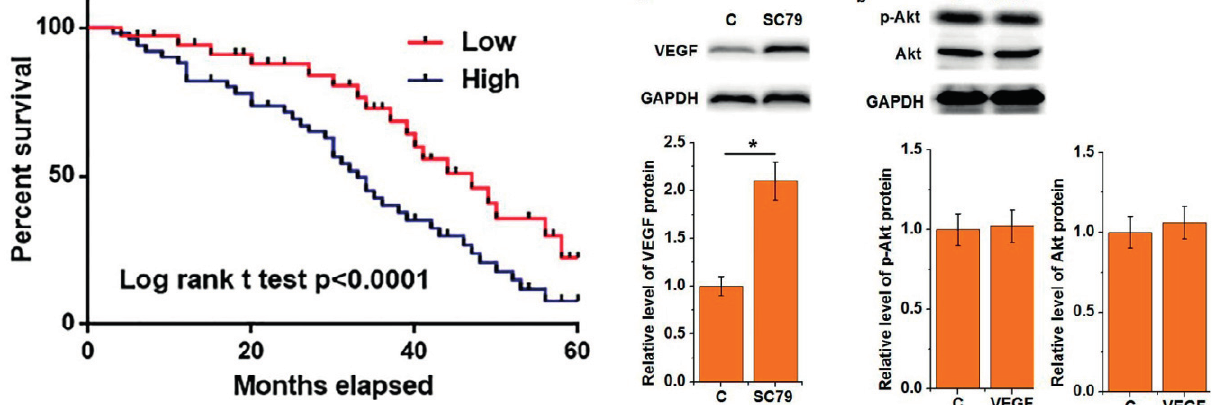
Fig. 5. Akt is likely a positive upstream positive regulator of VEGF in renal clear cell carcinoma cell line Caki-1. a. Effect of Akt activator on VEGF expression; b. Effect on VEGF treatment on expression and phosphorylation of Akt. * P <0.05.